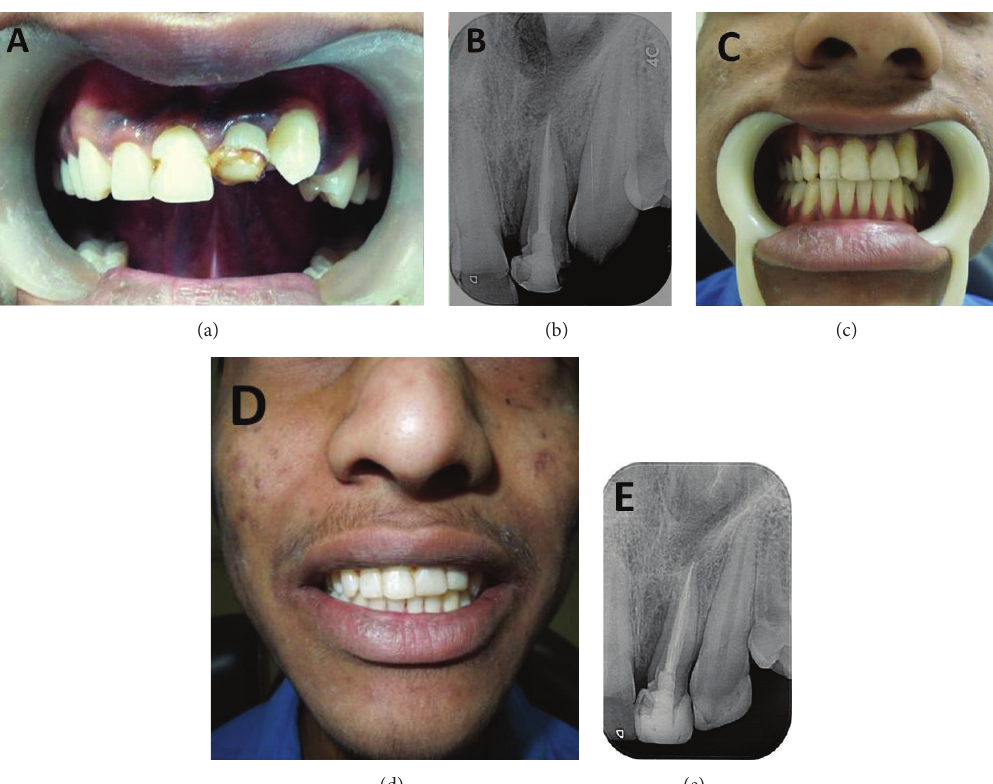
Figure 4: (a and b) Clinical and radiographic examination at 12 months revealed spontaneous eruption of canine and its more vertical placement. (c and d) Restoration of central incisor and canine with resin composite: a clinical view. (e) Restoration of central incisor and canine: a radiographic